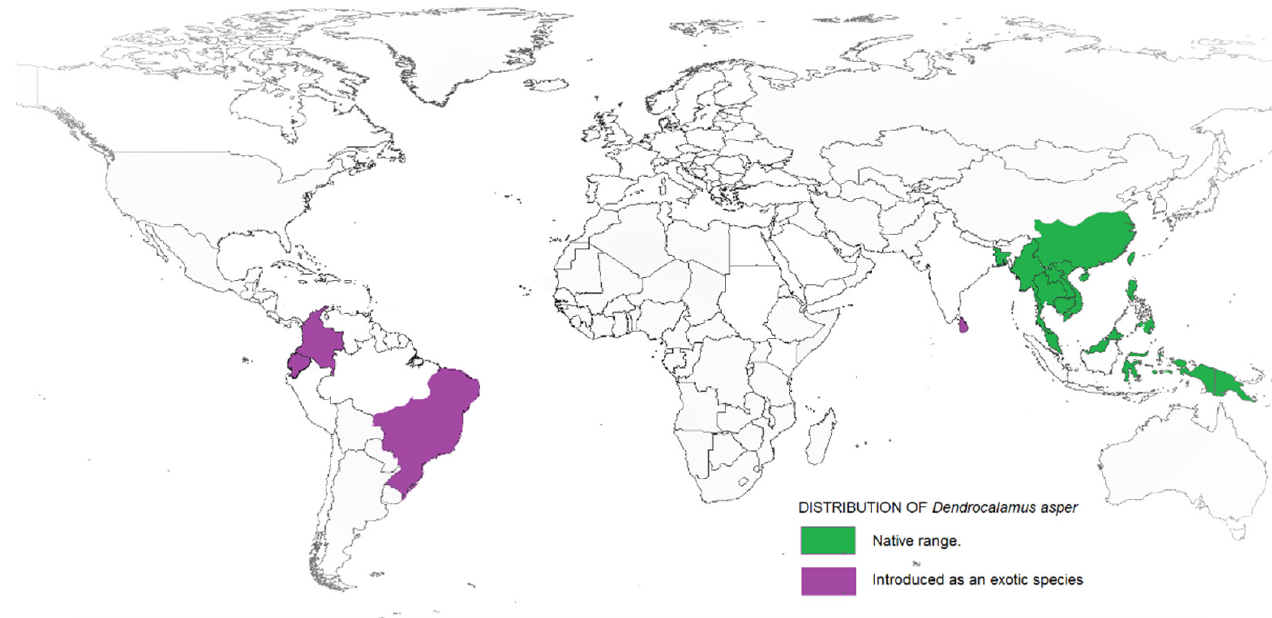
Figure 1. Range and distribution of D. asper in its native and introduced habitats.